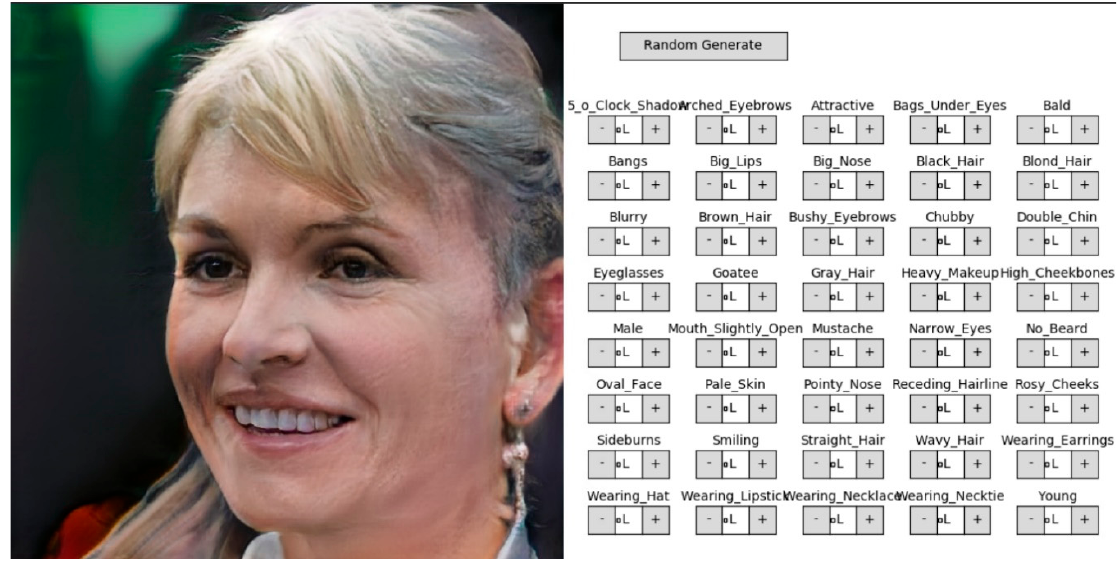
Figure 14. Demo of a Transparent Latent-Space Generated Adversarial Network (TL-GAN).